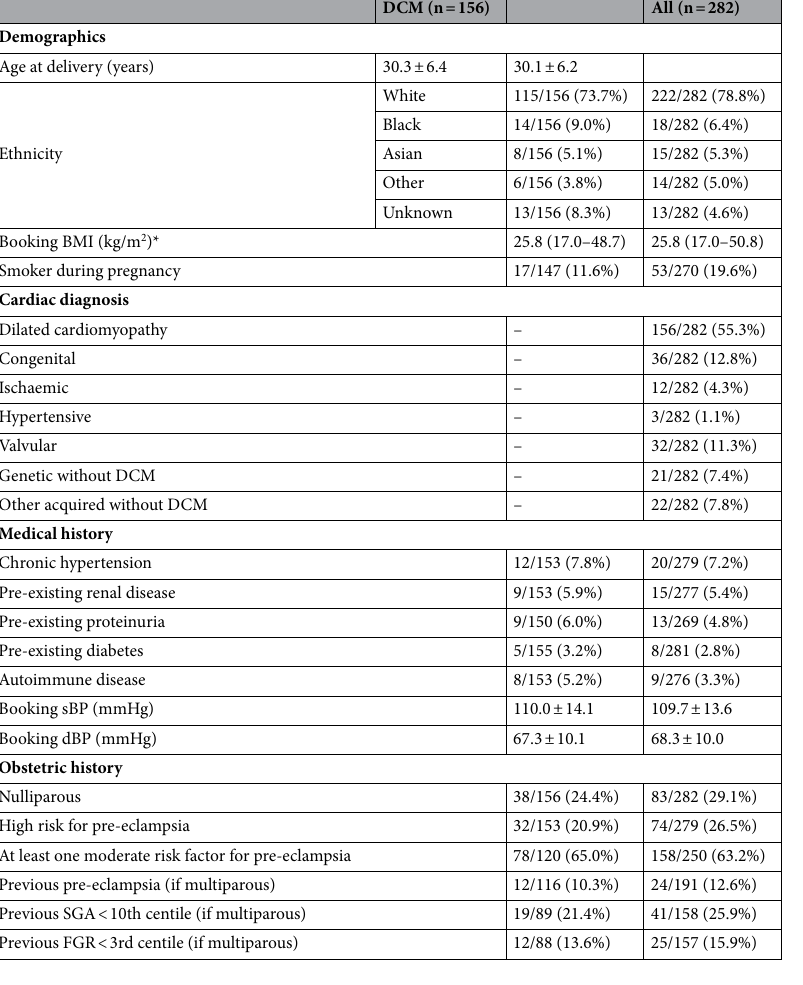
Table 1. Baseline characteristics. Frequencies: n/N (%). Mean ± standard deviation. *Median (range). Denominators vary between variables due to missing data. Congenital heart disease encompassed structural defects including coarctation of the aorta, patent ductus arteriosus, ventricular septal defect, pulmonary atresia, tetralogy of Fallot, transposition of the great arteries and truncus arteriosus. Genetic causes without DCM (dilated cardiomyopathy) include: hypertrophic obstructive cardiomyopathy, arrhythmogenic cardiomyopathy and left ventricular non-compaction cardiomyopathy. Other acquired causes without DCM include: previous PPCM, drug-induced and inflammatory. † High risk for pre-eclampsia is defined by presence of: pre-existing hypertension, renal, vascular or autoimmune disease, diabetes, previous pre-eclampsia, or two moderate risk factors. ‡ Moderate risk factors include: nulliparity, age ≥ 40 years, multi-fetal